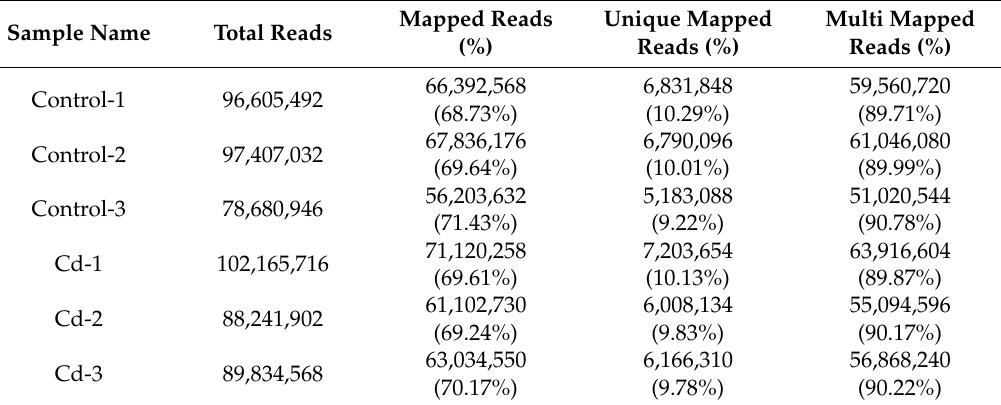
Table 2. Information of RNA-seq clean reads mapped with the reference transcriptome.